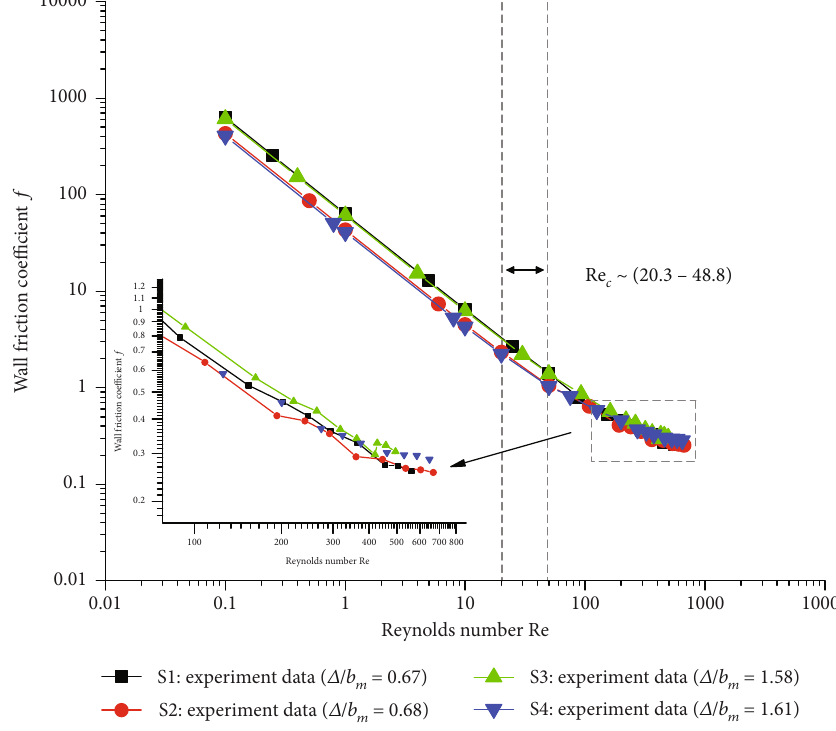
Figure 6: Wall friction coe ffi cient of rough fractures for specimens